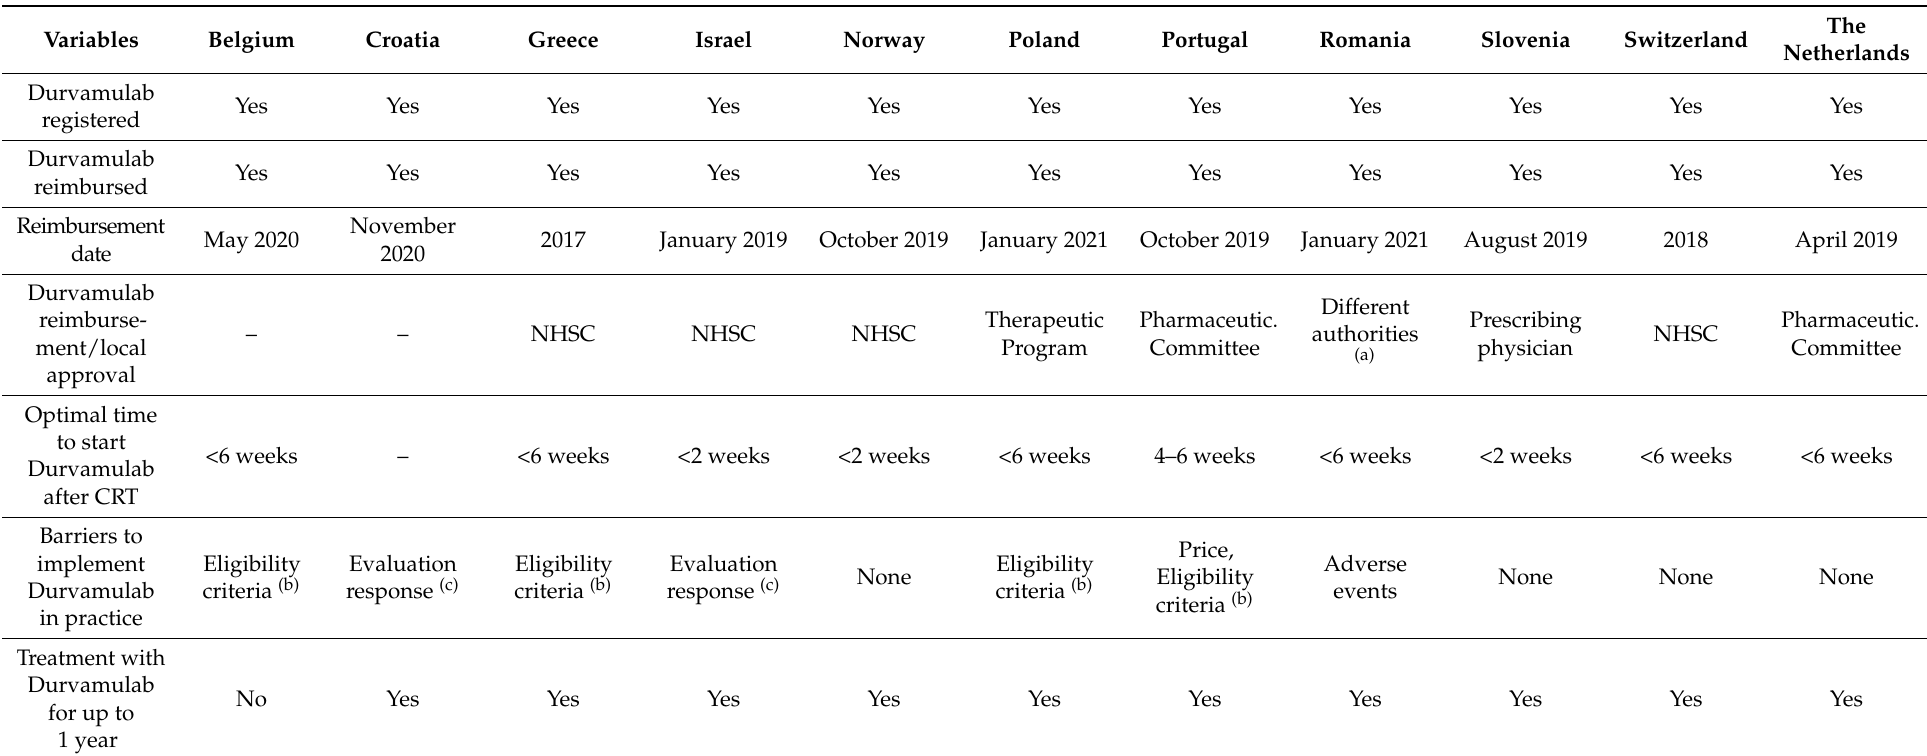
Table 4. Approval of Durvamulab and challenges for its implementation into daily clinical